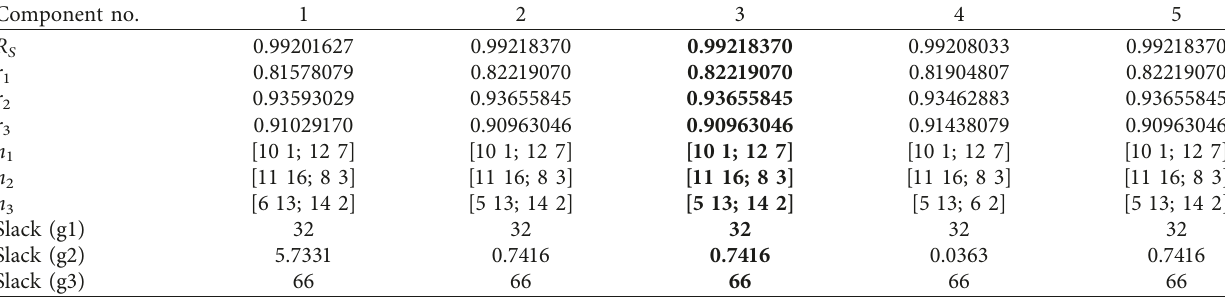
Table 12: Optimal component reliability and swapping strategy (Example 2).